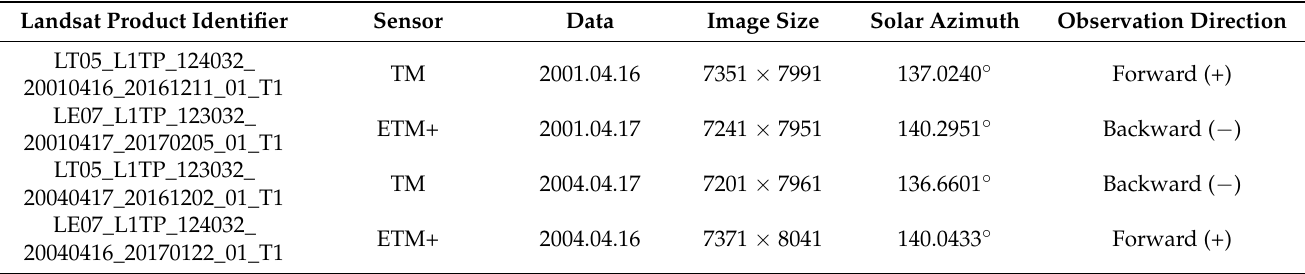
Table 2. Parameters of Thematic Mapper (TM)/Enhanced Thematic Mapper (ETM+) images.